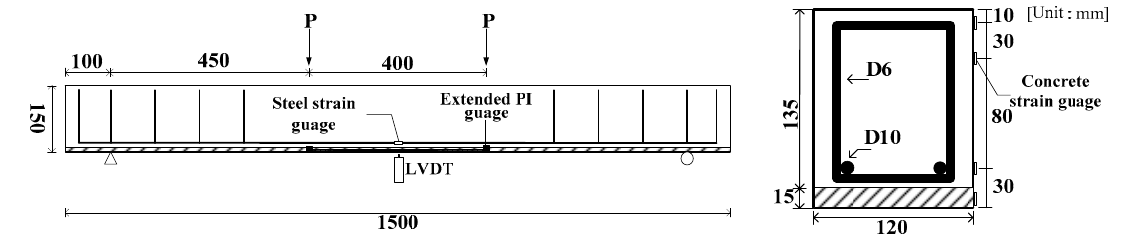
Figure 2. Specifications of study specimens.